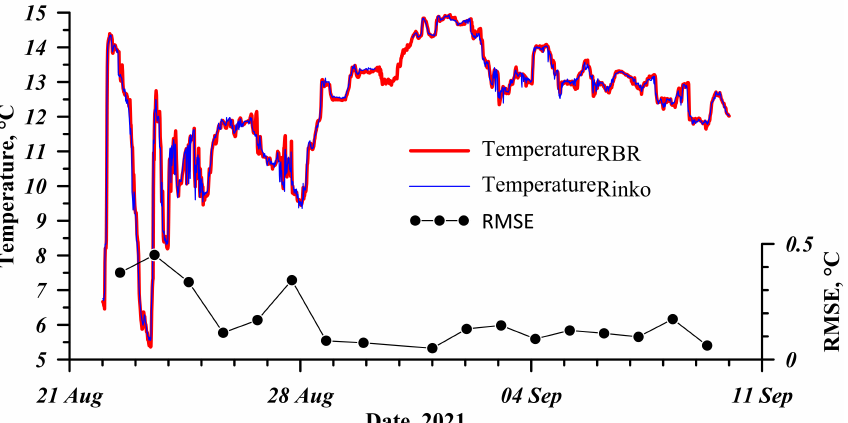
Figure 5. Comparison of temperature data measured by RBRSolo-T (red line) and AHMS (blue